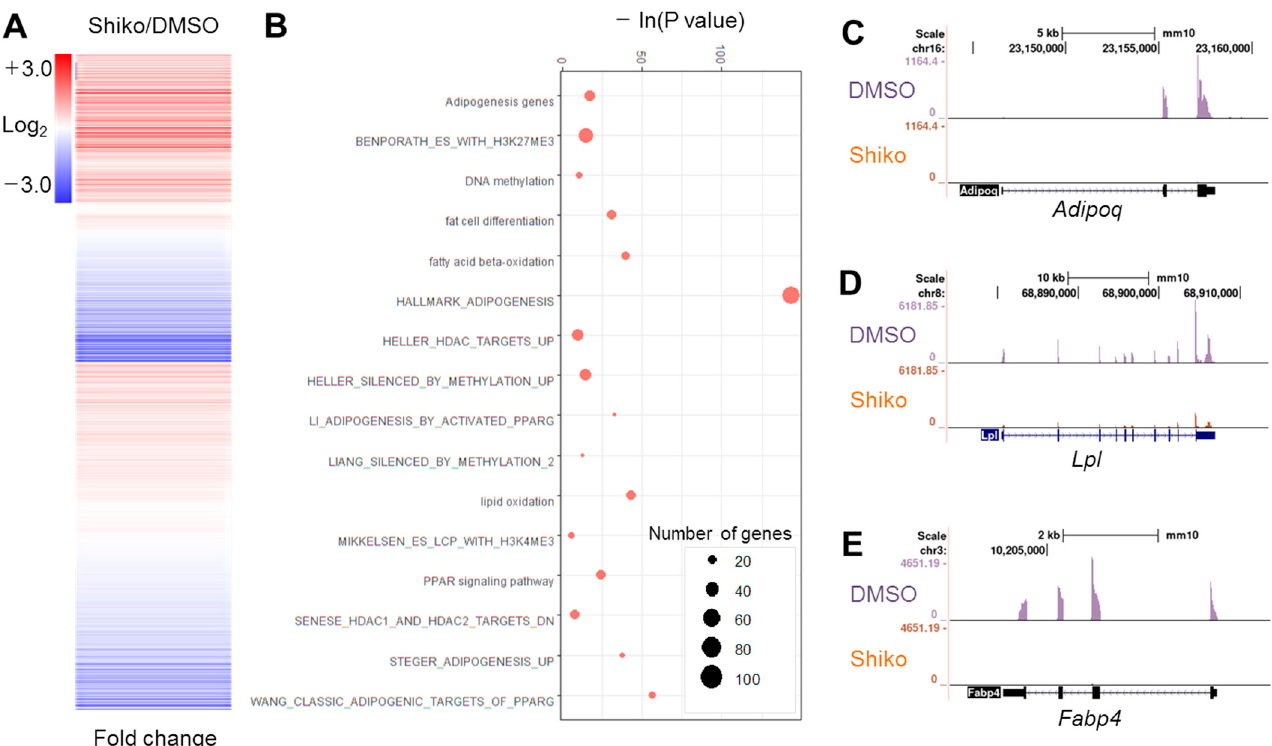
Figure 1. Genome-wide RNA-seq analysis. ( A ) Clustering analysis of 2406 genes with 1.5-fold changes following shikonin treatment. ( B ) Gene Ontology (GO) analysis of genes with 1.5-fold changes. ( C – E ) Bedgraph analysis of three adipogenic genes downregulated by shikonin treatment. Enrichment of tag fragments from RNA-seq results are shown in the gene bodies of Fabp4 ( C ), Adipoq ( D ), and Lpl ( E ).